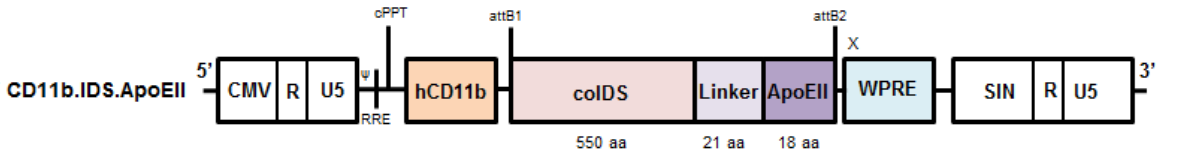
Figure 2. The CD11b.IDSApoEII lentiviral construct lentiviral vector under the CD11b promoter encoding for the codon-optimised human IDS gene followed by a flexible linker and the ApoEII peptide as a tandem repeat [57].